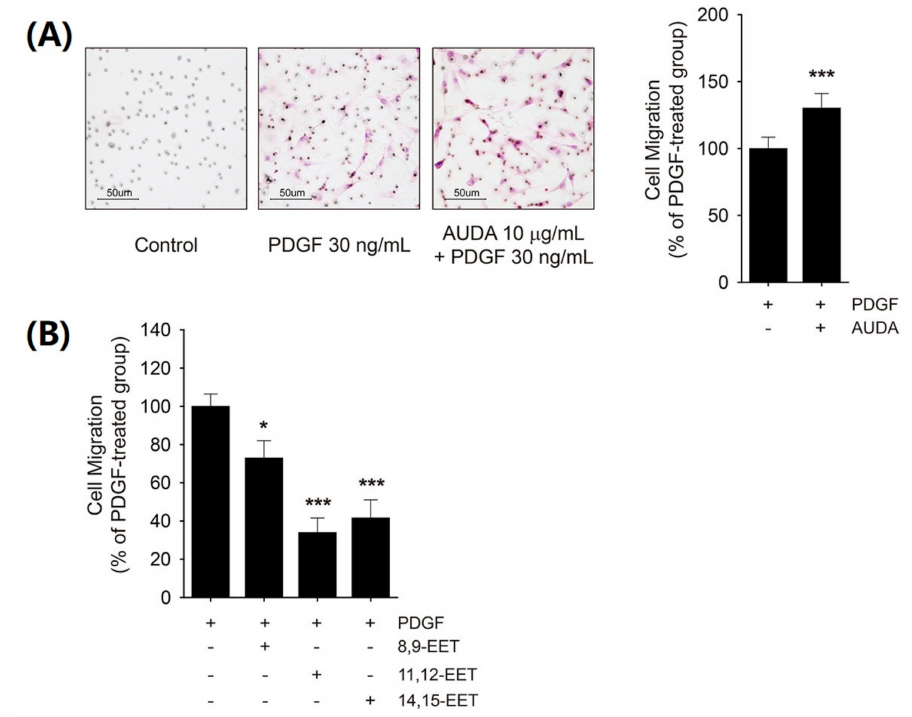
Figure 3. Differential effects of AUDA and EETs on PDGF-induced VSMC migration. ( A ) Effect of AUDA on PDGF-induced VSMC migration. Cell migration was determined via Boyden chamber assay in VSMC incubated with vehicle control or 10 µ g/mL AUDA for 24 h. Culture media containing 30 ng/mL PDGF was added to the lower chamber as chemoattractant; ( B ) Effect of EETs on PDGF-induced VSMC migration. VSMCs were incubated with vehicle control, 8,9-EET, 11,12-EET, or 14,15-EET (1 µ M, respectively) for 24 h. Cell migration was determined as described in ( A ). Statistical significance is indicated as * p < 0.05; *** p < 0.001 vs. PDGF-treated